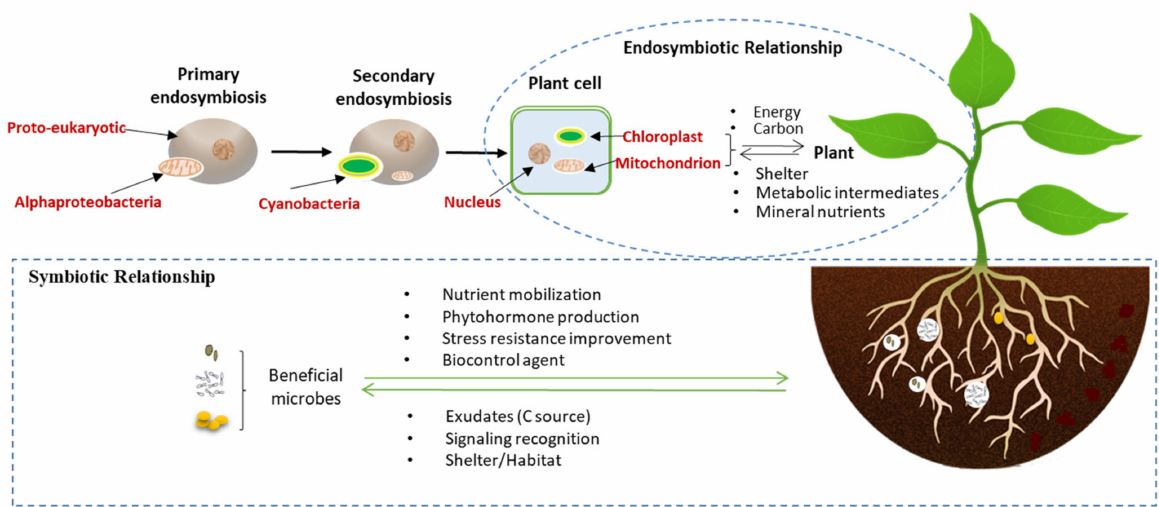
Figure 1. The origin of mitochondria and chloroplasts, as modified prokaryotes that have become plant organelles [8], the endosymbiotic relationship between chloroplast, mitochondrion, and plant itself, and the symbiotic relationships between the beneficial microbes and the host plant. Beneficial microbes include plant growth promoting bacteria and fungi. The shelter and habitat created by the plant host provide a regulated environment and energy source, enhancing the survival of the symbionts and